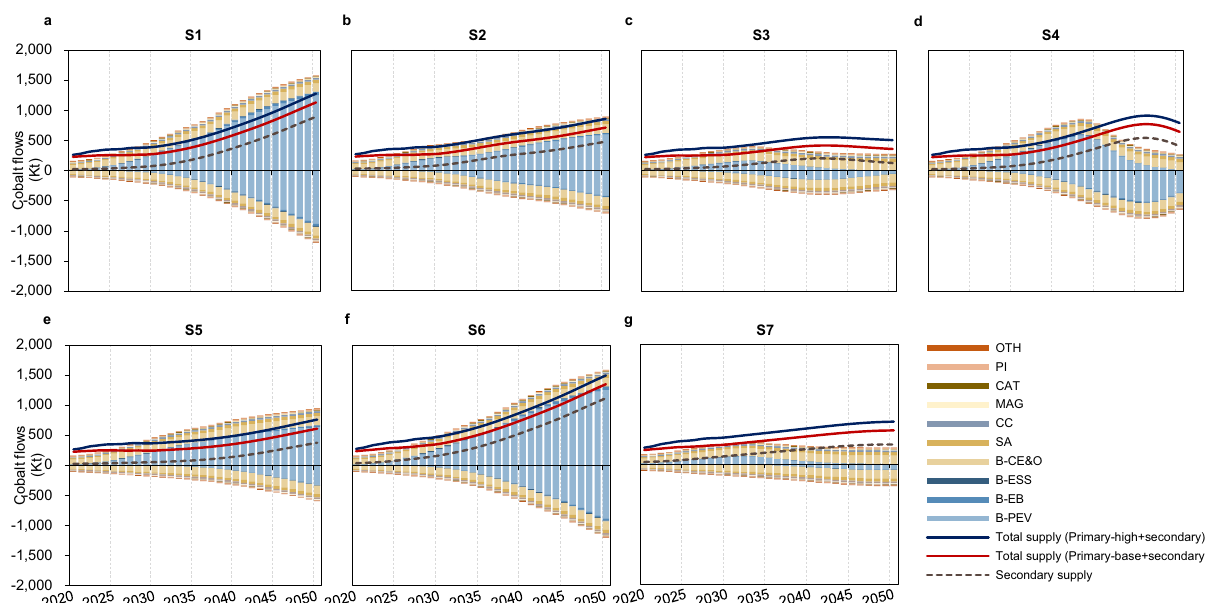
Fig. 3 Prospective global cobalt demand (positive values), scrap generation (negative values), and total supply (primary + secondary) under the seven scenarios. a S1: state-of-the-art battery cathode technology scenario as the reference scenario; b S2: low-cobalt battery cathode technology scenario; c S3: LFP-dominant cobalt-free battery cathode technology scenario; d S4: next-generation cobalt-free battery cathode technology scenario; e S5: extending battery lifetime scenario; f S6: high recycling rate scenario; and g S7: the most optimistic technology scenario. The scenarios are detailed in Table 2 in the Methods section. The primary-base and primary-high indicate two primary supply scenarios, as shown in Table 1 and